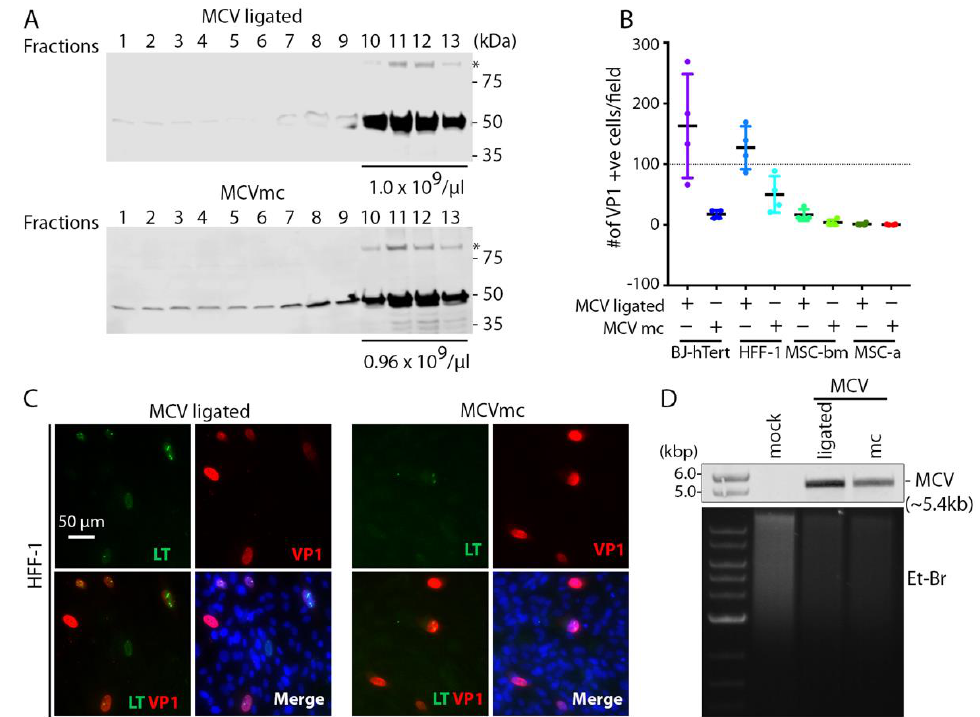
Figure 2. MCVmc is infectious in primary cells. ( A ) Western blot of MCV-ligated and MCVmc virions fractions from Opti-Prep (iodixanol) gradient purification. Fractions 1–13 (top to bottom) are indicated. * Indicates VP1 dimer. Fractions 10 through 13 were mixed and MCV genome copy